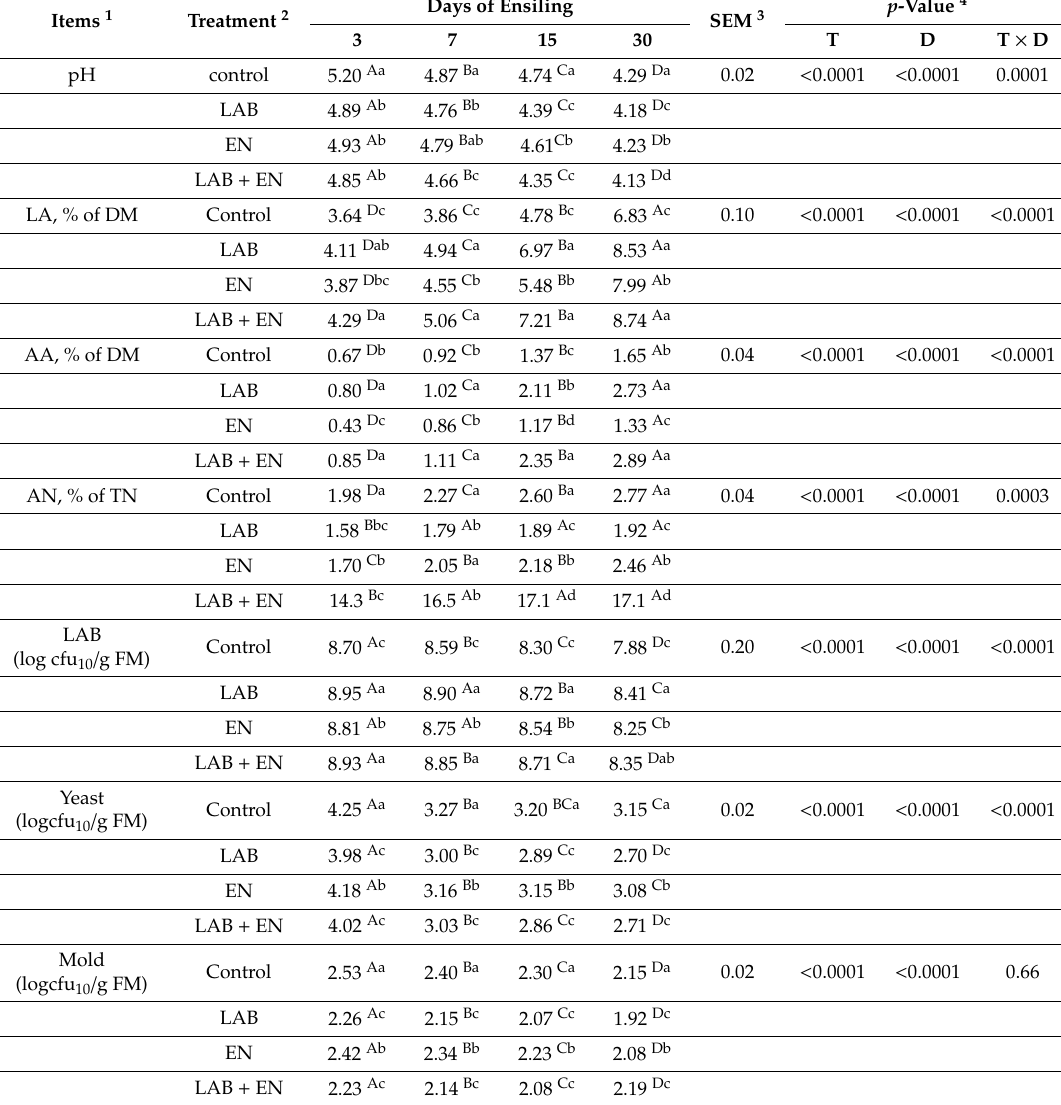
Table 3. E ff ects of lactic acid bacteria and / or fibrolytic enzyme on the fermentation characteristics and microbial population of total mixed ration silages containing wet corn gluten feed and corn